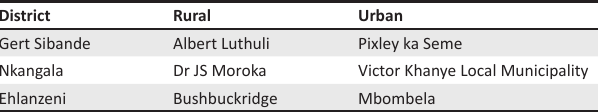
TABLE 1: Rural and urban municipalities chosen per